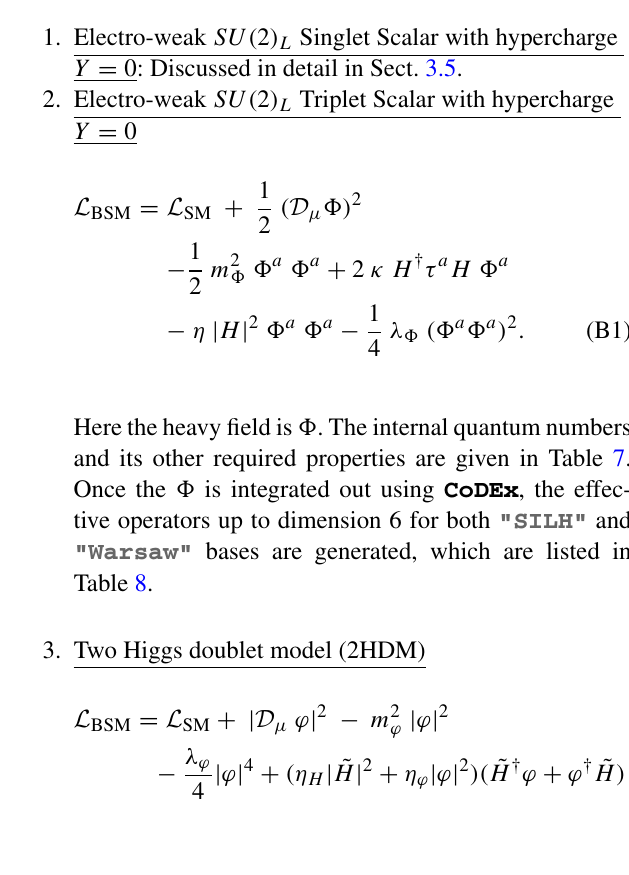
Table 7 SM gauge quantum numbers of BSM fields BSM